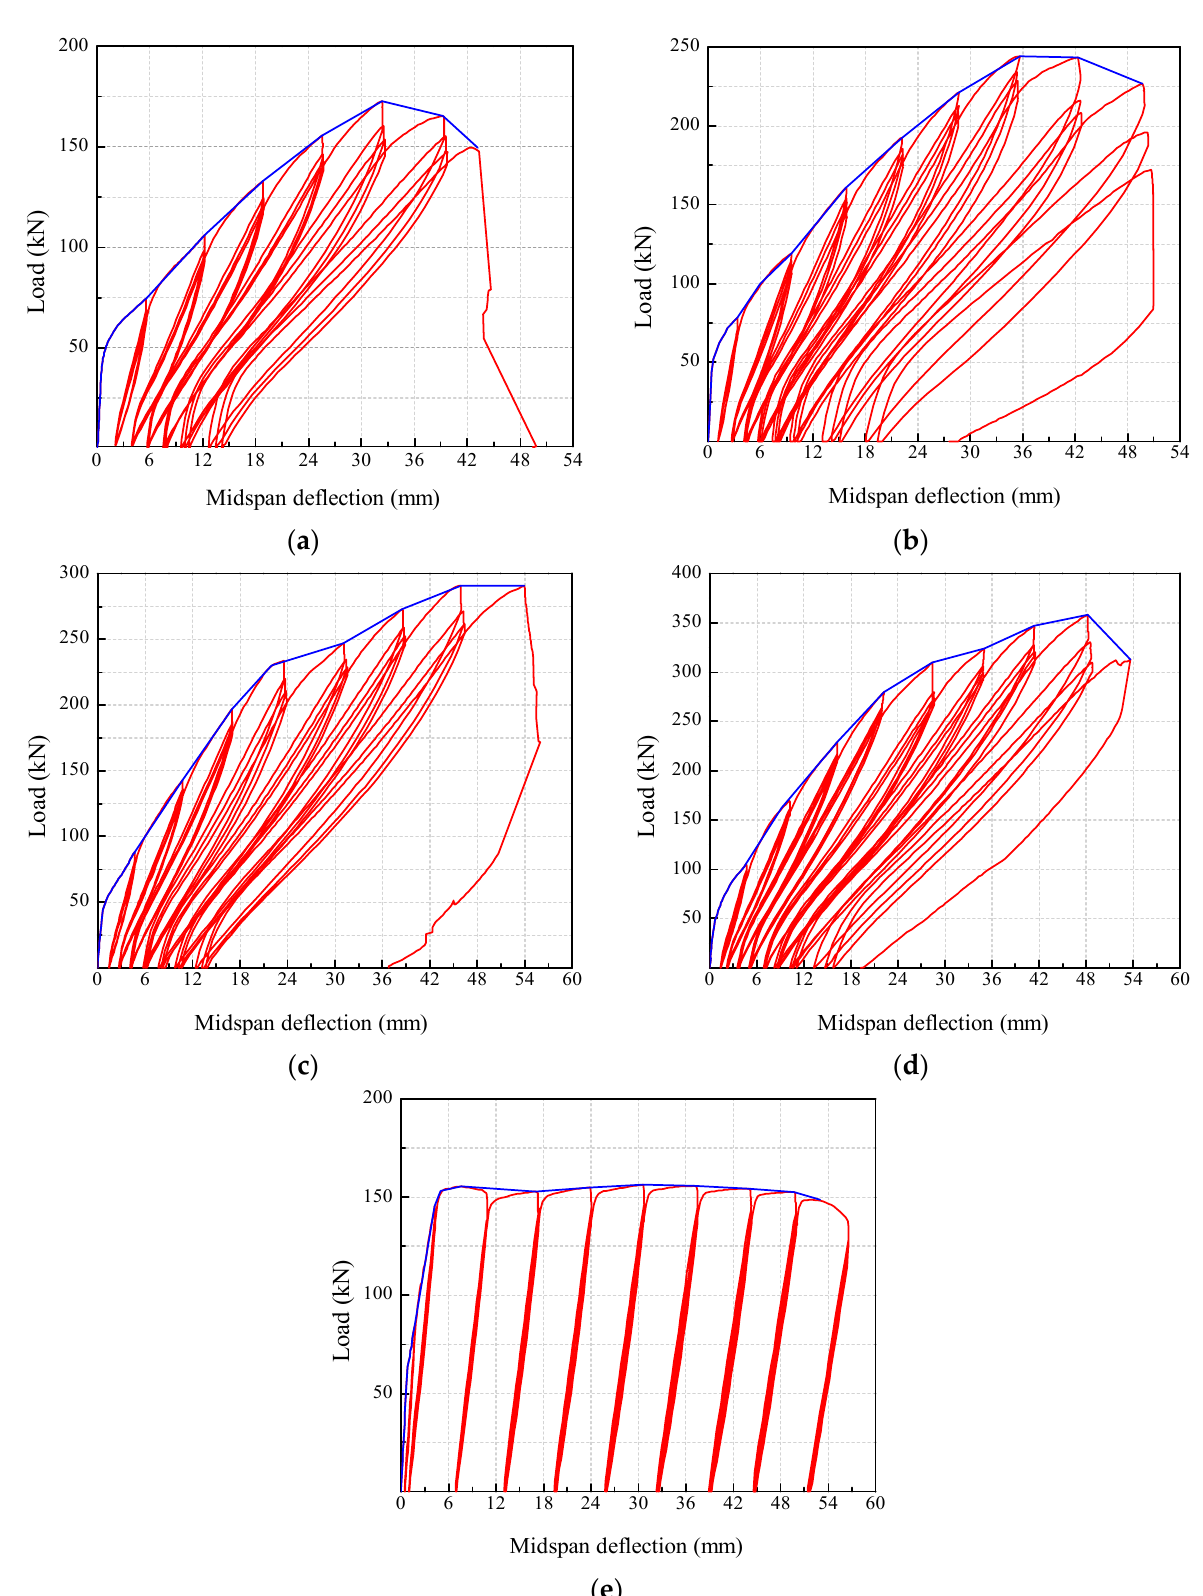
Figure 10. Load-deflection curves: ( a ) B56; ( b ) B77; ( c ) B115; ( d ) B165; ( e ) S77.